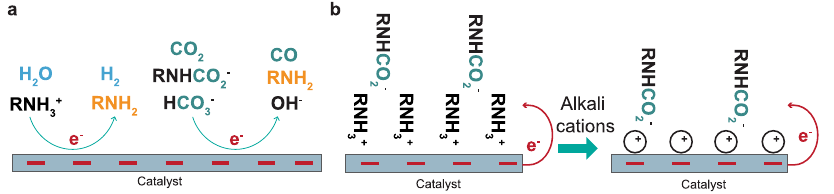
Fig. 5 | Speciation of amine-based capture media in sequential and integrated routes and their impacts on CO 2 electrochemical conversion. a Proposed inte- grated CO 2 absorption and electrolysis routes in amine-based